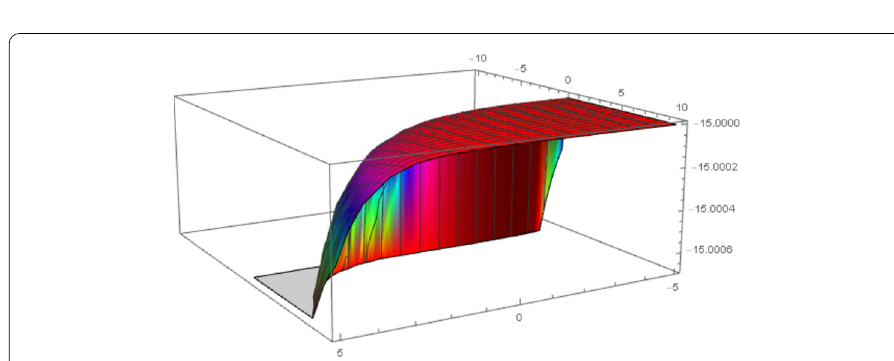
Figure 5 Soliton solution of u 6 ( η ) for α = 0, a 1 = 1, λ = –1, V = 0, b 1 = 1, k = 3